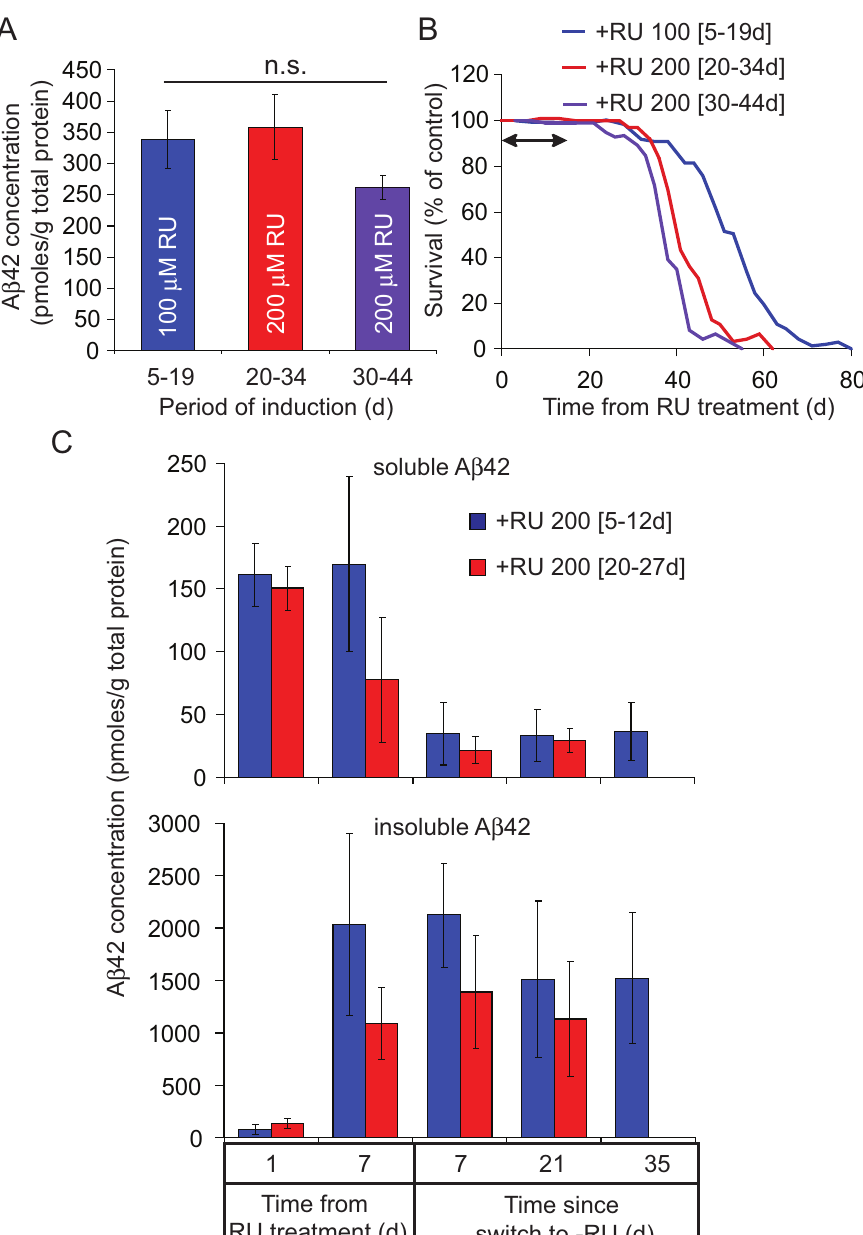
Figure 3. Older flies are more vulnerable to a standardised dose of Arctic A b 42 peptide. (A & B) UAS-Arctic A b 42/ + ; elavGS/ + females were treated, for 2 weeks, with 100 m M RU486 from 5 days (RU 100 [5–19d]) and 200 m M RU486 from 20 (RU 200 [20–34d]) and 30 (RU 200 [30–44d]) days post-eclosion, and were maintained on RU486-free medium prior to and following the pulse period. (A) Total A b 42 protein levels (soluble and insoluble as measured by GnHCl extraction) were equivalent at the end of the RU pulse when comparing each age of induction. Data are expressed as means 6 SEM (n=5) and were compared using one-way ANOVA and Tukey’s HSD post-hoc. No significant differences were observed. (B) Survival, expressed as a percentage of non-RU486-treated controls, plotted from the age of RU486 induction. Arrow indicates the induction period. Older flies exhibit a significantly greater reduction in relative survival following RU treatment ( P , 0.05 comparing RU 200 [20–34d] and RU 200 [30–44d] with RU 100 [5–19d] and RU 200 [20–34d] with RU 200 [30–44d], Wilcoxon matched pairs sign rank test). Raw survival curves are depicted in Fig S4A. (C) UAS- Arctic A b 42/ + ; elavGS/ + females were pulsed for 1 week with 200 m M RU486 from 5 (RU 200 [5–12d]) and 20 (RU 200 [20–27d]) days post-eclosion, to equalise the total A b 42 level in young versus old-induced flies (see Fig S3). Soluble and insoluble A b 42 was fractionated (see methods) and measured by ELISA at 1 and 7 days following induction, then 7, 21 and, in the case of RU 200 [5–12d] flies, 35 days following the switch to RU486-free food. Data are expressed as means 6 SEM and were analysed by two-way ANOVA (n=4). No significant differences were observed comparing RU 200